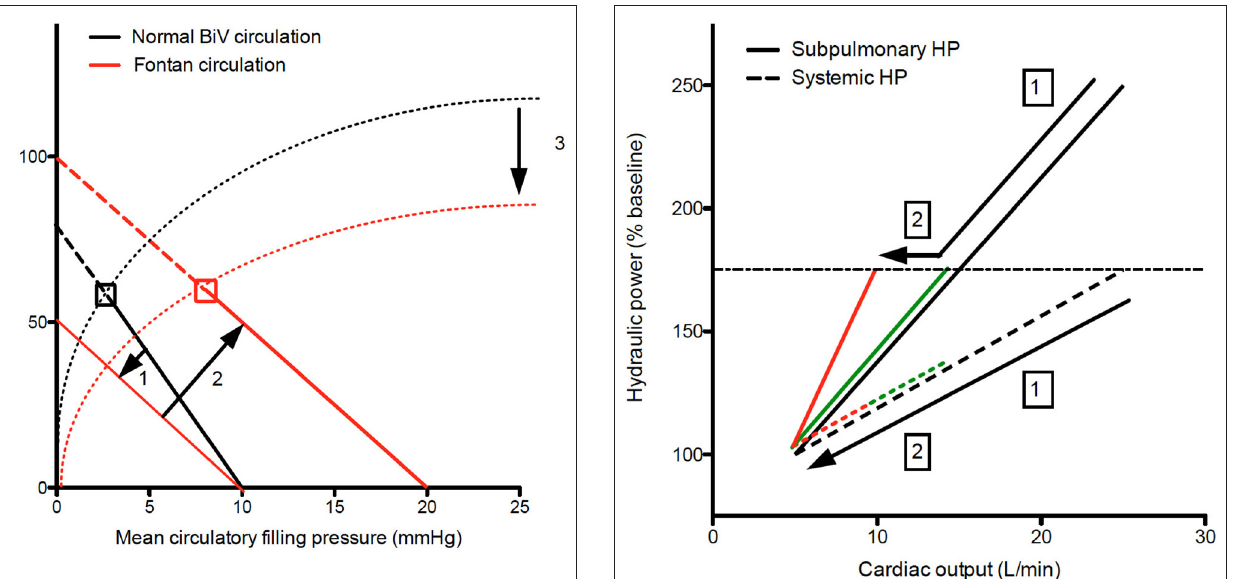
FIGURE 1 | Venous return curve. In Fontan patients the venous return curve shows on downward rotation due the pulmonary vasculature (and hence PVR) being incorporated in venous return (1). Volume load brings back venous return at the level of biventricular circulation at the expense of an increase in mean circulatory filling pressure (2). Finally since left atrial pressure is the backpressure for venous return, increased left atrial pressure will result in decrease cardiac output. The dashed lines indicate the Frank Starling curve, indicating lower contractility (3).